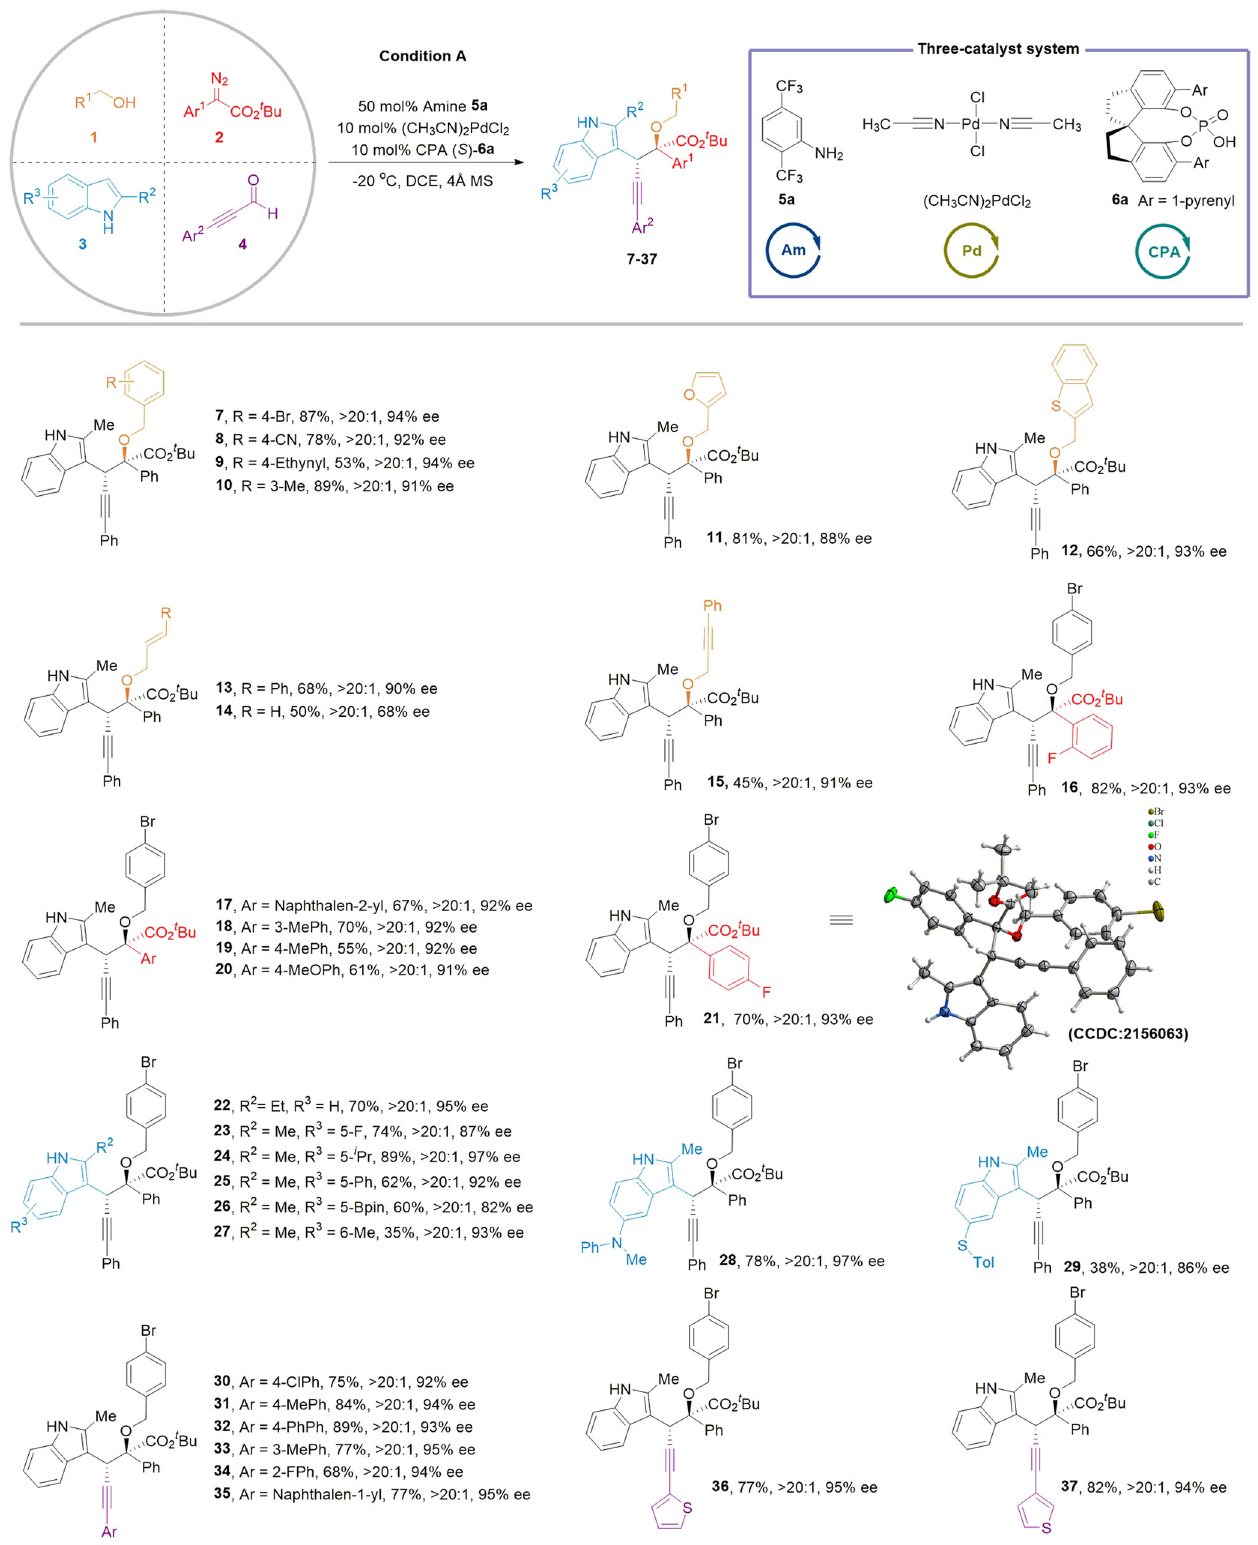
Fig. 2 | Substrate scope of enantioselective four-component reactions of alcohol, diazoester, indole and aldehyde derivatives. Standard conditions: 1 / 2 / 3 / 4/5a/[Pd]/6a =0.6/0.3/0.2/0.6/0.1/0.01/0.02mmol. 2, 3 in 4.0mL dry DCE